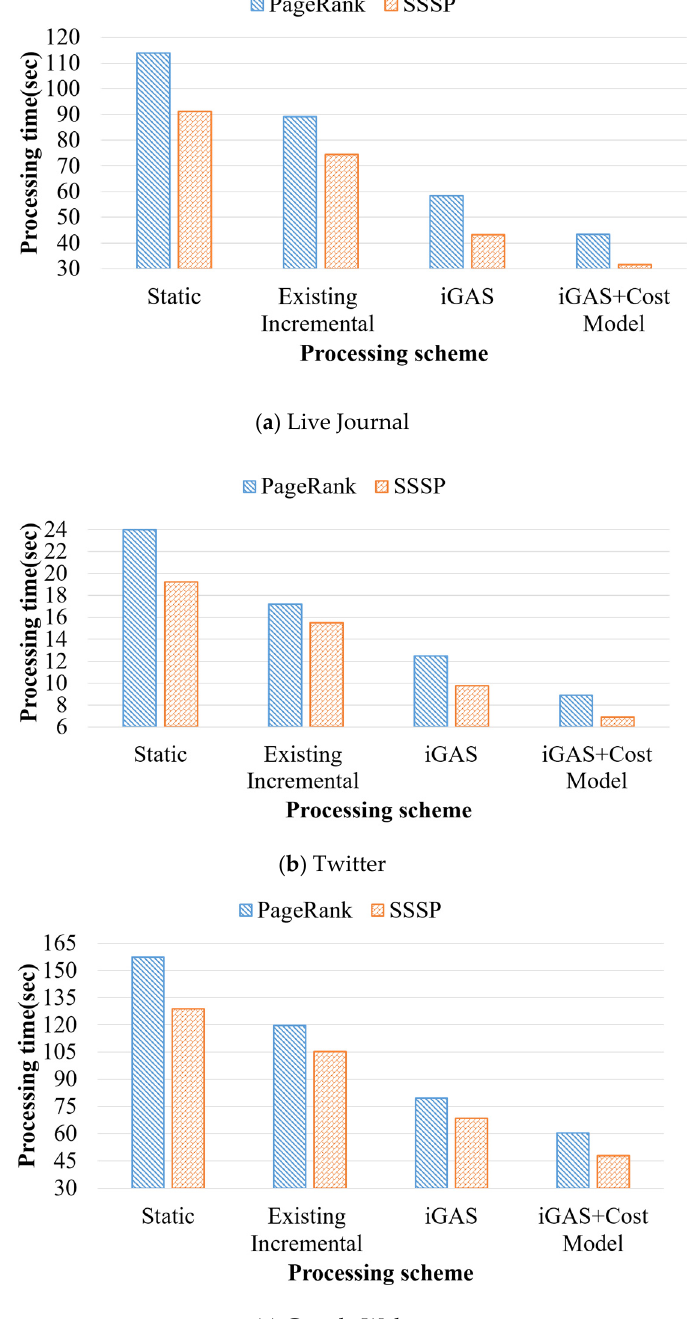
Figure 9. Processing times on three types of data sets.